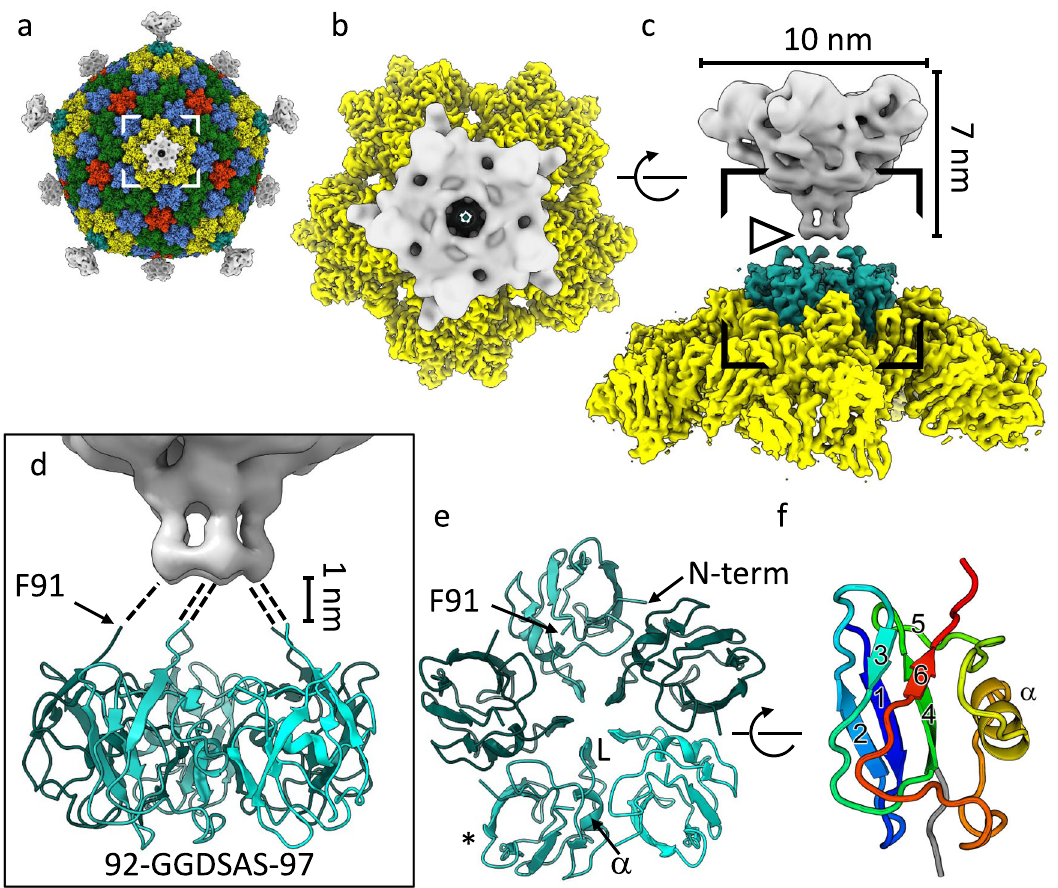
Fig. 4 | Φ CjT23 vertex. a A composite cryo-EM map of Φ CjT23 bacteriophage capsidcombininglocalizedreconstructionsofthefourMCPtrimers(yellow,green, red,andblue),pentonbase(cyan),andspike(gray). b Aclose-upofonevertexseen from the top of the area indicated in a . c The same view as in b , rotated by 90° around the axis indicated. The dimensions of the spike, corresponding to the external domains of spike protein P13, are indicated. Note the discontinuation in the density (arrowhead). d A close-up of the area indicated in c . The model of the penton base part of the spike is shown in ribbon (cyan). The ordered part of the map ends around the area occupied by G92. Putative linker regions spanning the 1-nm gap between the penton base and the external part of the spike (gray) are